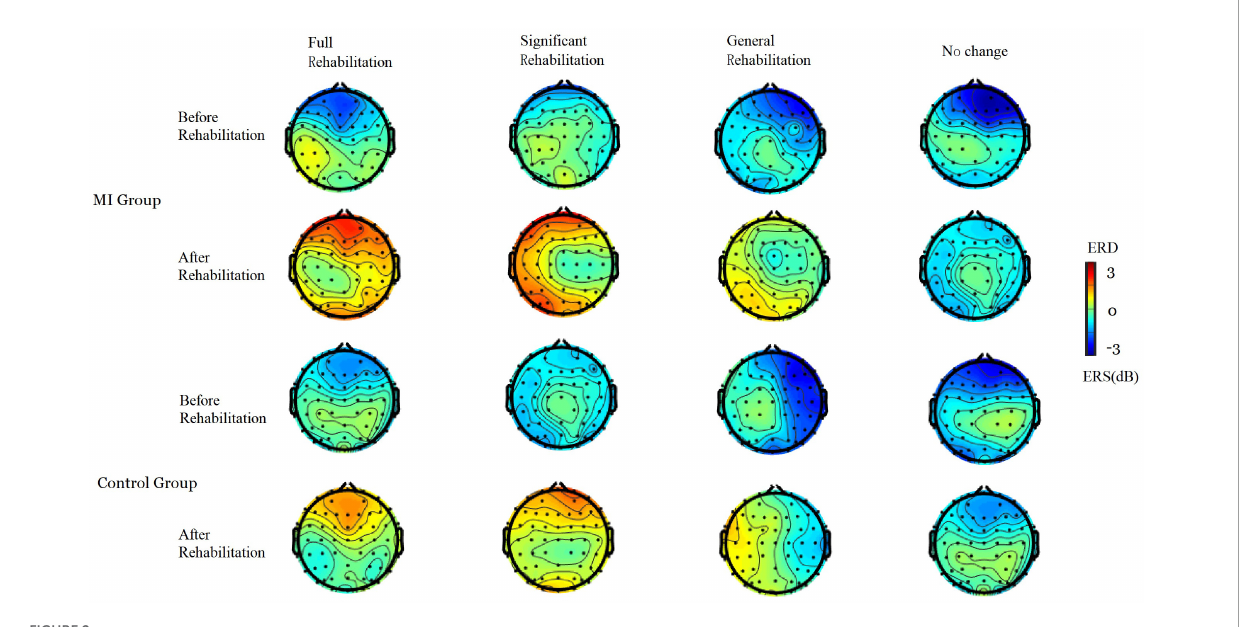
FIGURE2 Brain topographic of MI group and control